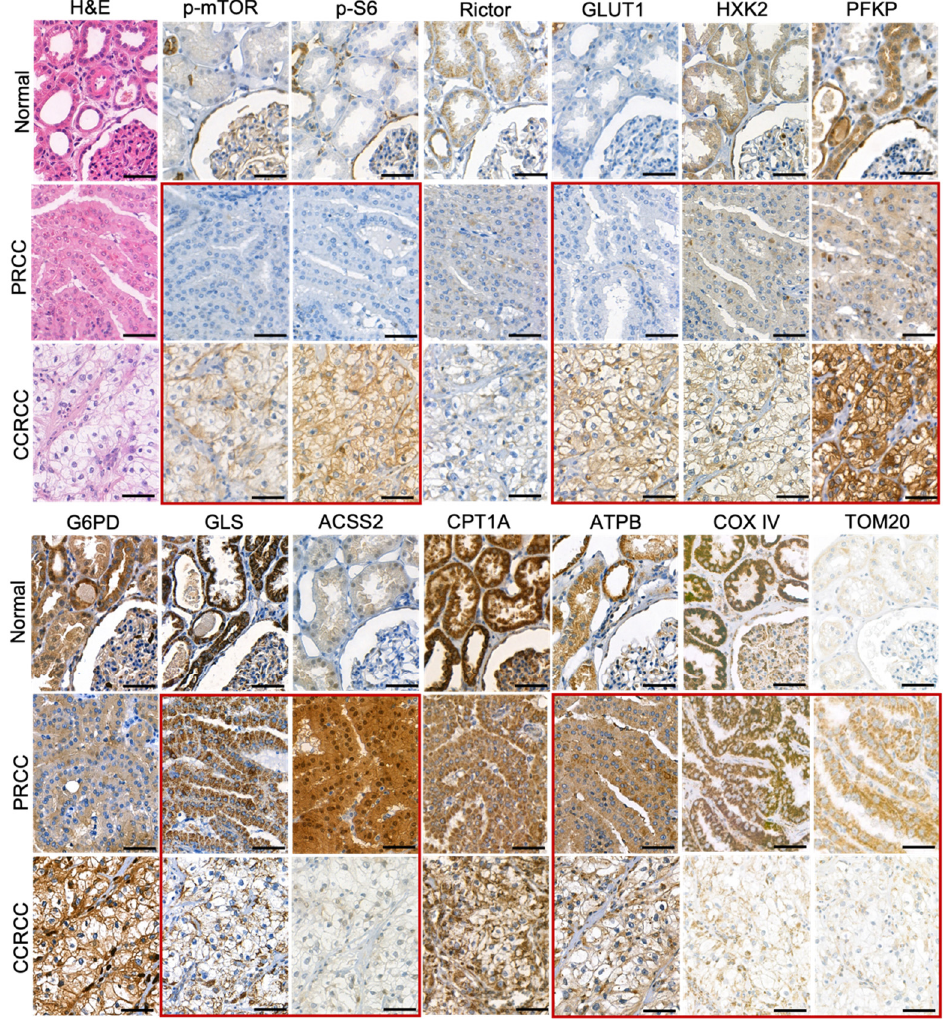
Figure 1. Immunohistochemical analysis of mTOR and metabolic pathway markers in papillary (PRCC) and clear cell renal cell carcinomas (CCRCC). The expression of p-mTOR (marker for mTOR kinase activity), p-S6 (mTORC1 activity marker), Rictor (marker of the amount of mTORC2), GLUT1, HXK2, PFKP (glycolysis markers), G6PD (pentose phosphate pathway marker), GLS (glutaminolysis marker), ACSS2 (marker for acetate consumption), CPT1A (fatty acid β -oxidation marker), ATPB (OXPHOS marker), COX IV, and TOM20 (mitochondrial markers) was analyzed in normal kidney, PRCCs, and CCRCCs. The detected characteristic differences in enzyme expression profiles between PRCCs and CCRCCs were highlighted by red frame. Immunohistochemistry (DAB chromogen–brown) and hematoxylin counterstaining were used. Scale bars indicate 50 μ m.